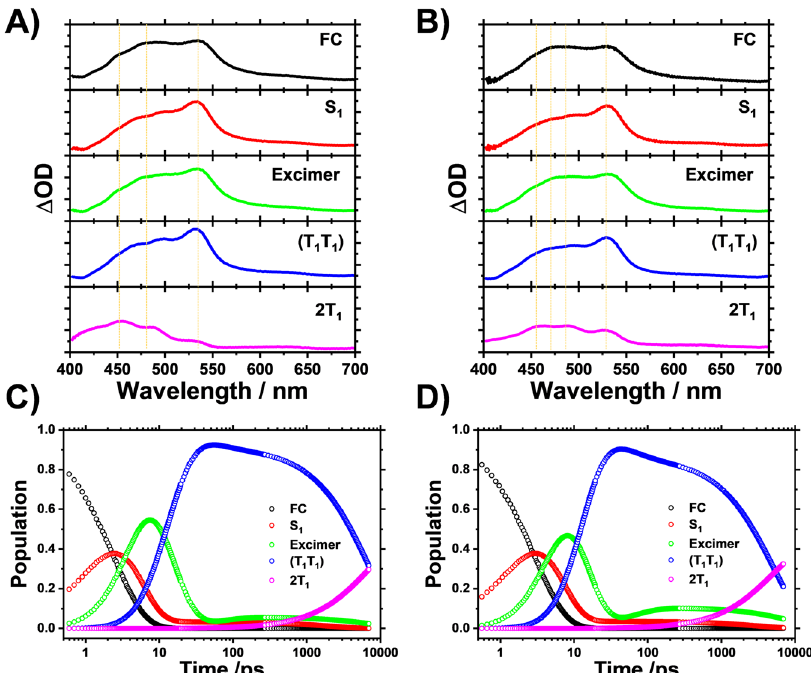
Fig. 6 Species-associated difference spectra and population changes of intermediates for Syn -DPyB obtained from the kinetic analysis for Kinetic Model (4) in n -hexane and acetonitrile. A , B Species-associated difference spectra in A n -hexane and B acetonitrile. C , D Population changes of intermediates in C n -hexane and D acetonitrile. The solid lines are the concentrations obtained from the kinetics analysis. The open circles represent the measure time